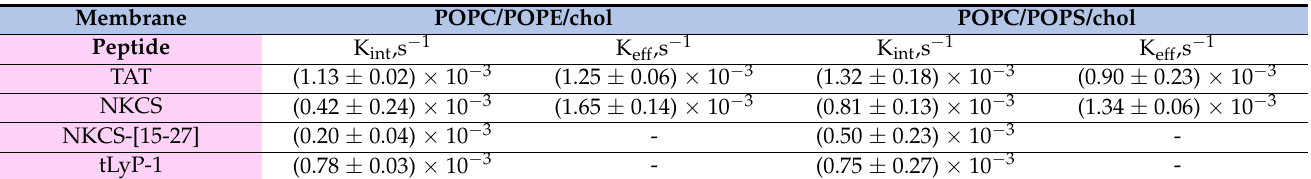
Table 1. Internalization of peptides and efflux rates of AF 488 in POPC/POPE/chol and POPC/POPS/chol containing GUVs.